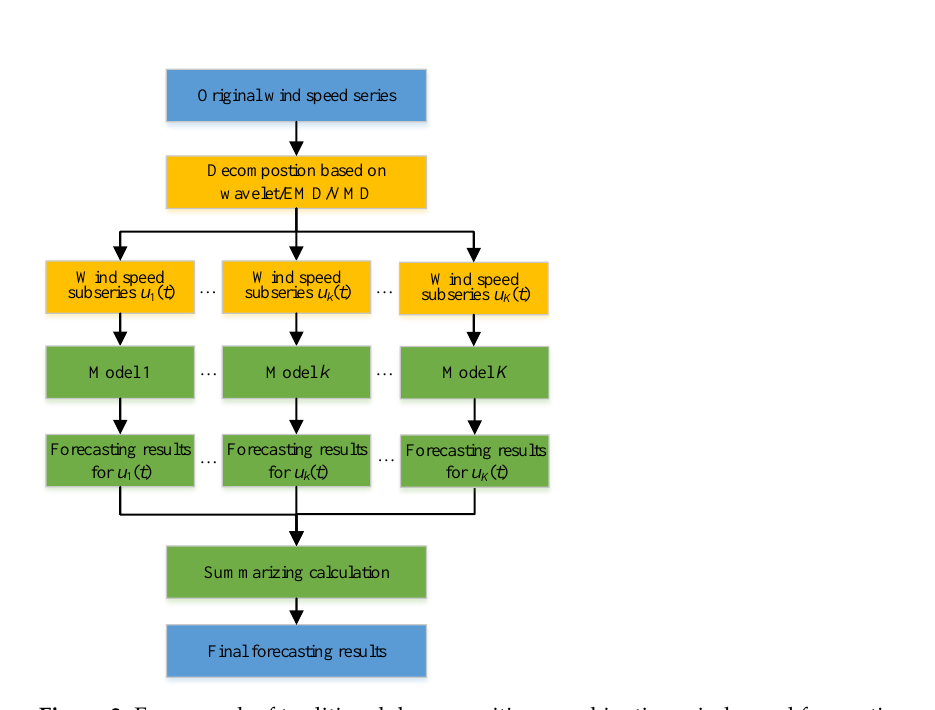
BLS 1 ARIMABLS nr ... BLS-ARIMA model Figure 5. The framework of the EVMD-SR-BLS-ARIMA hybrid wind speed forecasting model. As shown in Figure 6, the forecasting process of the EVMD-SR-BLS-ARIMA forecast- ing model is as follows: Step 1: Initialize the number of forecasting cycles k , k u , n 0 , n 1 , and n r to 0; set the input model wind speed time series length, N s , and forecasting times, M . Step 2: Using the EVMD method, the wind speed time series [ X (1 + k ), …, X ( N s + k )] is decomposed into K subseries u ( k ); calculate the sample entropy of each subseries and find the minimum sample entropy, En samp,min .